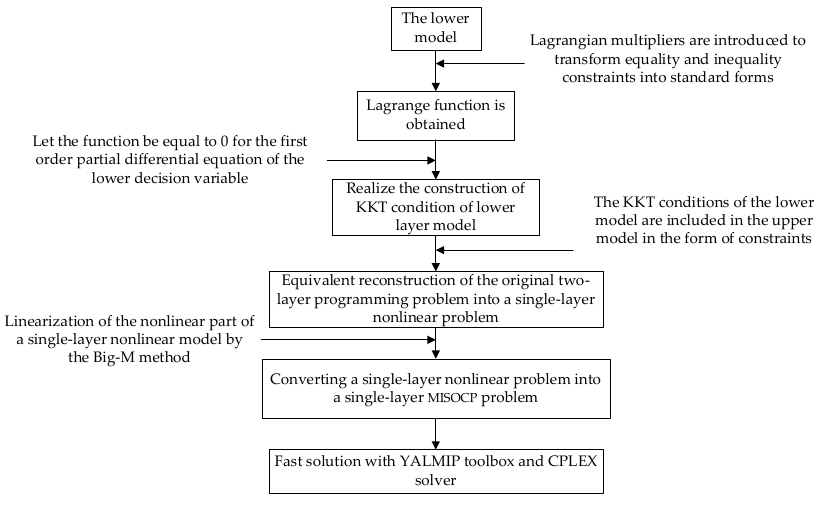
Figure 2. Model processing and solving.